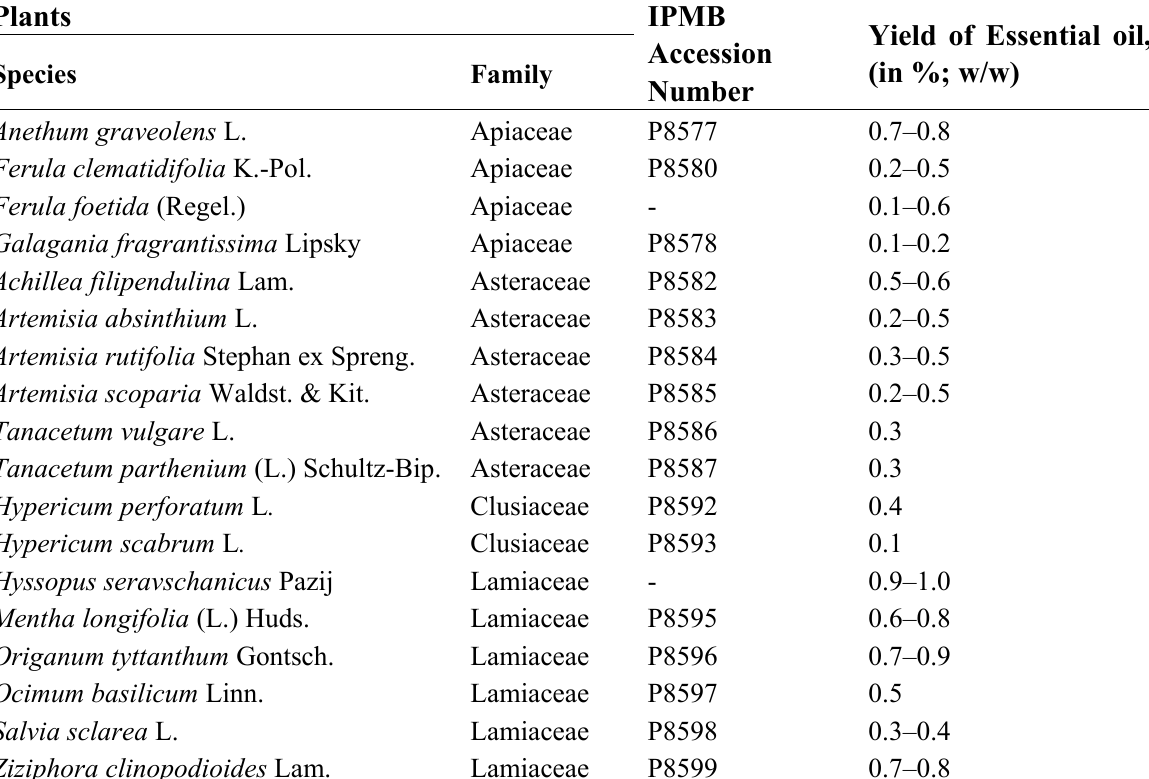
Table 1. Origin of samples and yield of essential